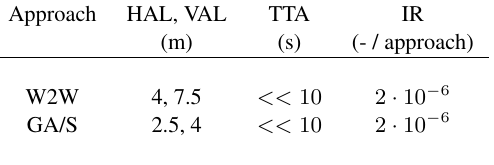
Table 2: High level integrity requirements defined in CLOSE- SEARCH for W2W and